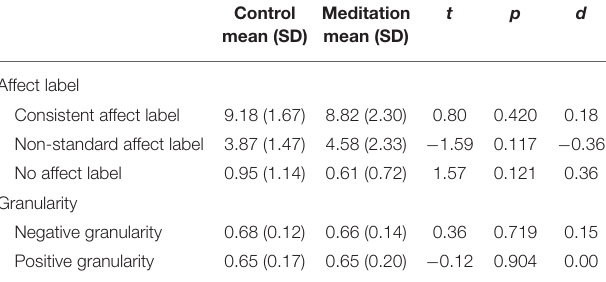
TABLE 5 | Group differences (meditation intervention vs. control condition) in emotional